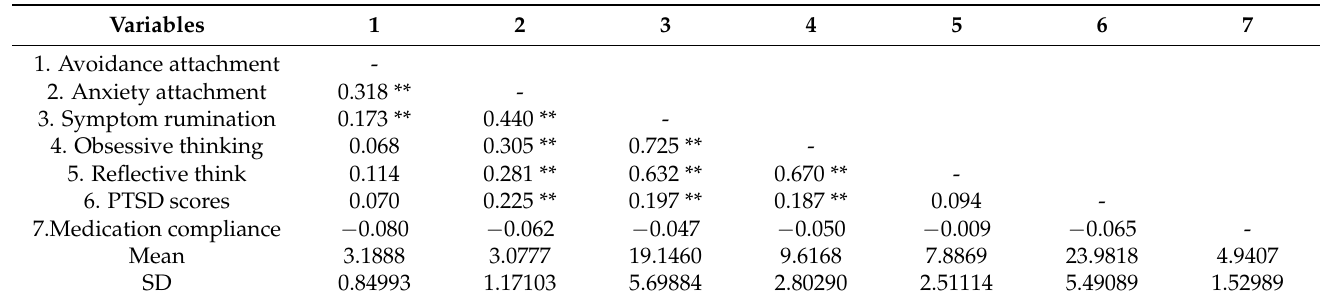
Table 1. The mean, standard deviation, and correlation coefficient of each measurement index score ( n = 274).